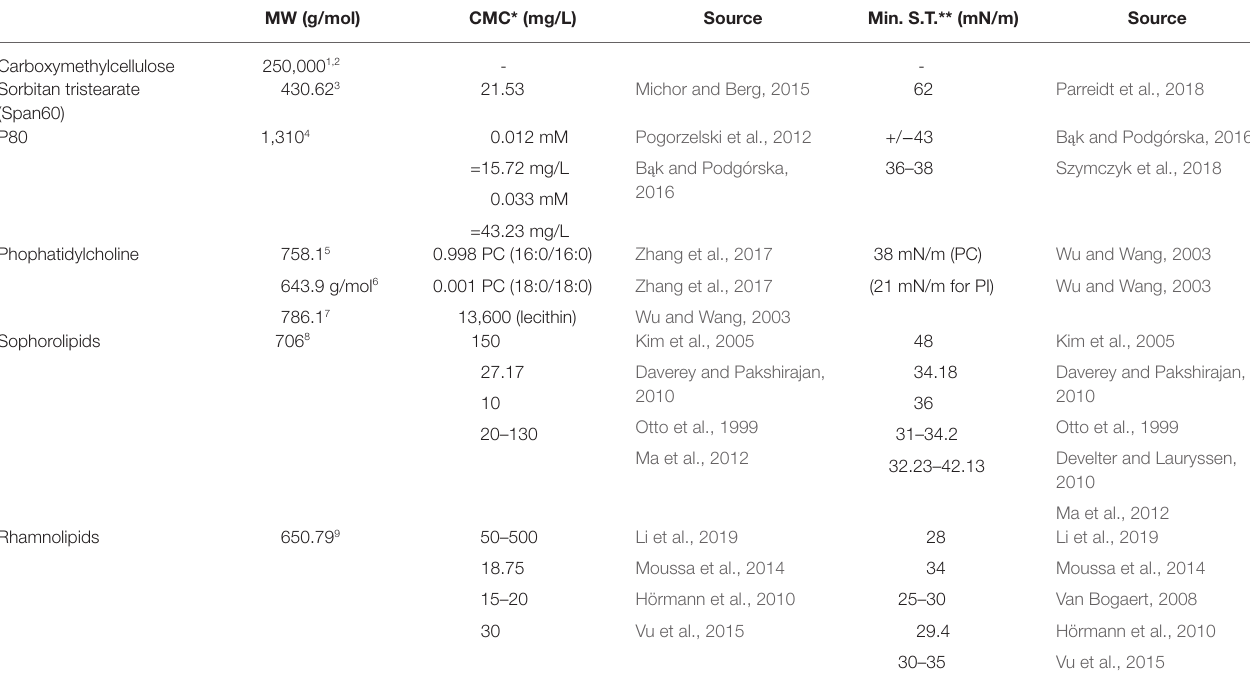
TABLE 1 | Emulsifier characteristics of sodium carboxymethylcellulose, Span60, P80, phosphatidylcholine (major component of soy lecithin), sophorolipids, and